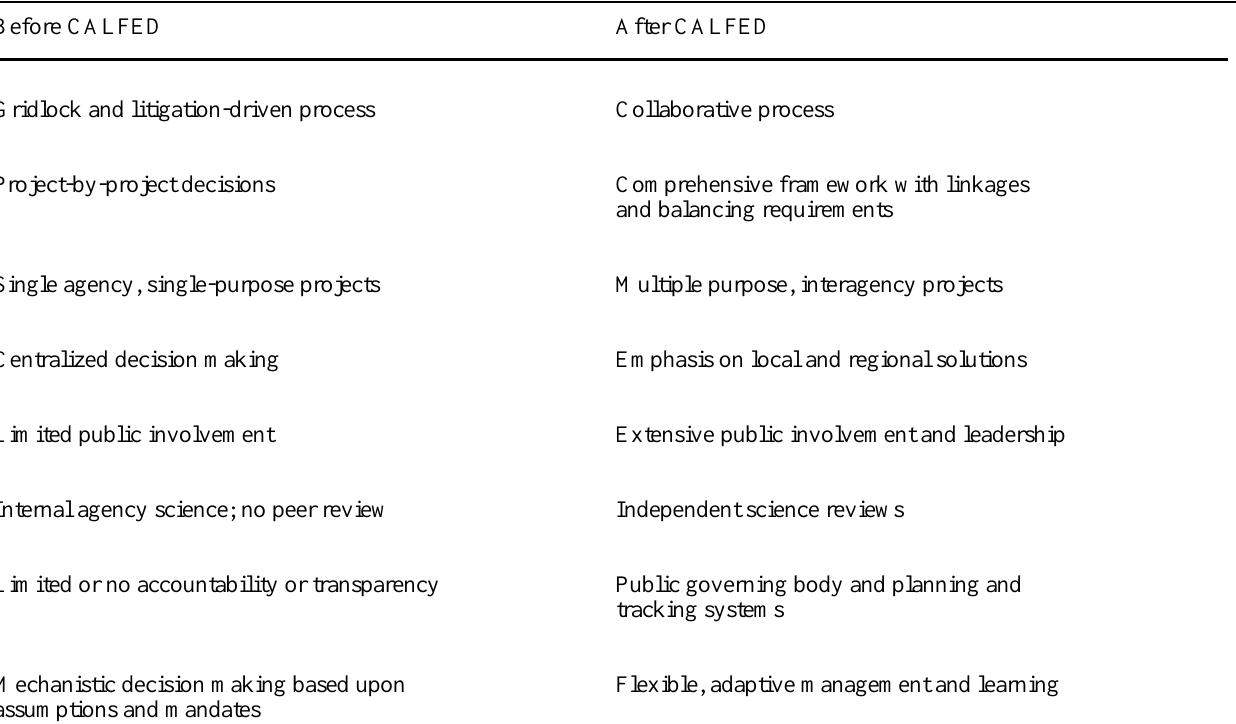
Table 1. Comparison of governance heuristics before and after CALFED. Before